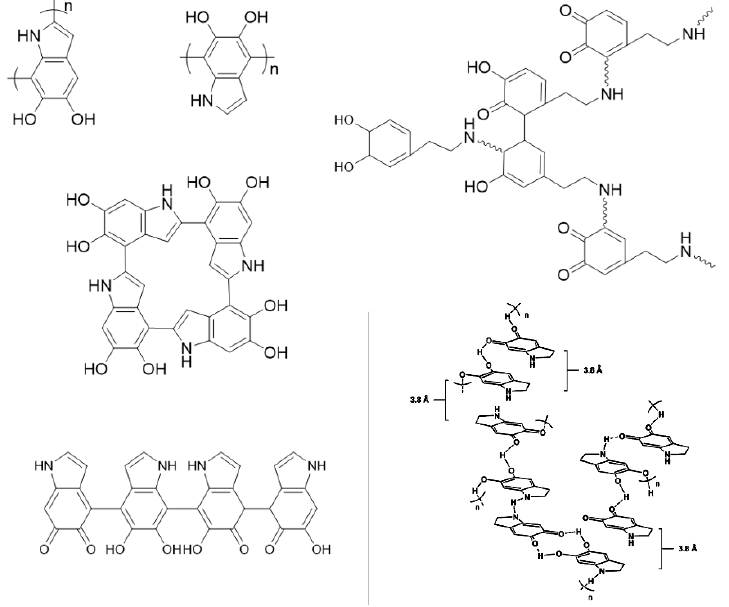
Figure 14. Schematic illustration of the other structures found in the literature for the PDA.